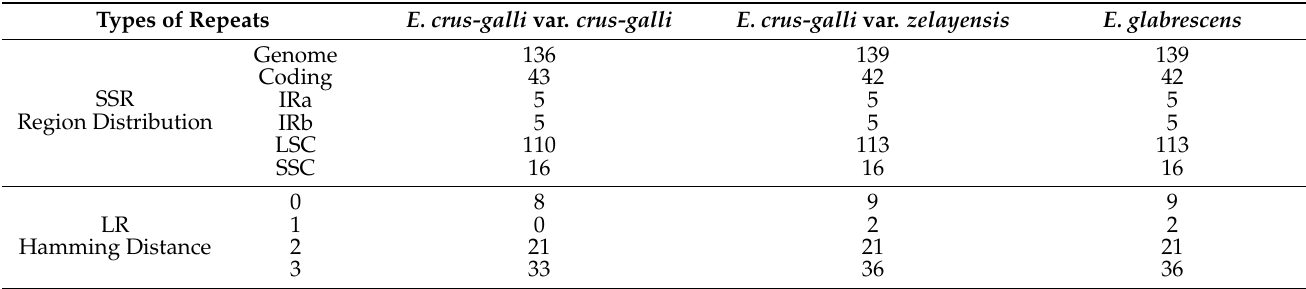
Table 5. SSRs and LRs in three barnyard grass